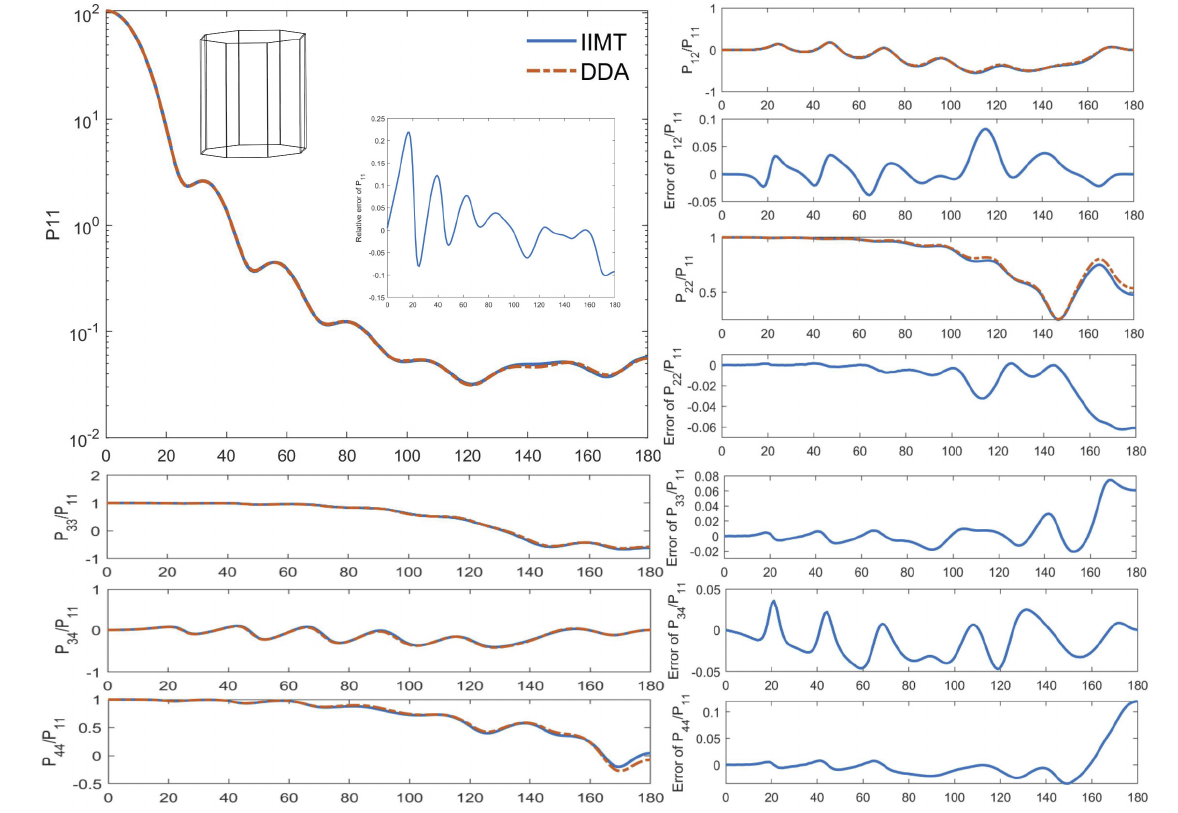
Figure 8. The phase matrices and their errors calculated by the IIM T − matrix and DDA methods for small octagonal prism particles with random orientations. The abscissa is the scattering angle. The solid line is the IIM T − matrix model and the dashed is DDA model.